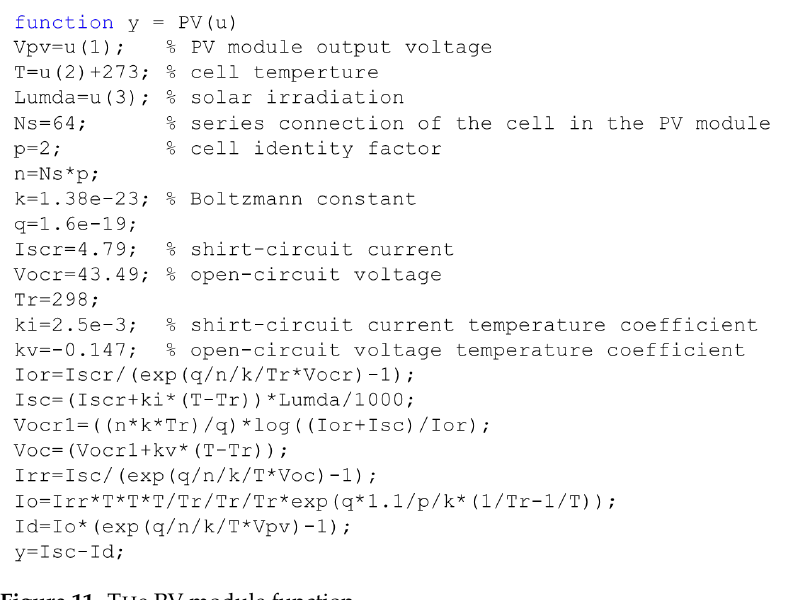
Figure 10. PV array model construction and verification: ( a ) with n p = 2.